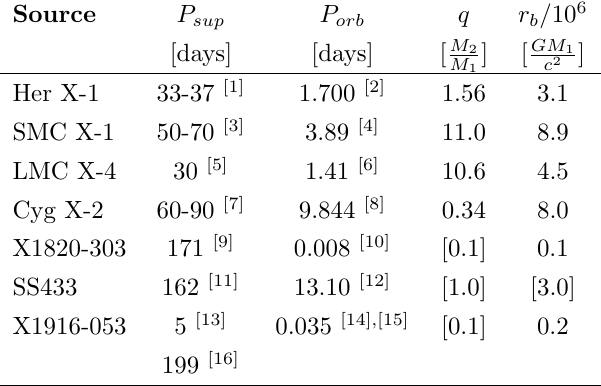
Table 1: System parameters for included XRBs